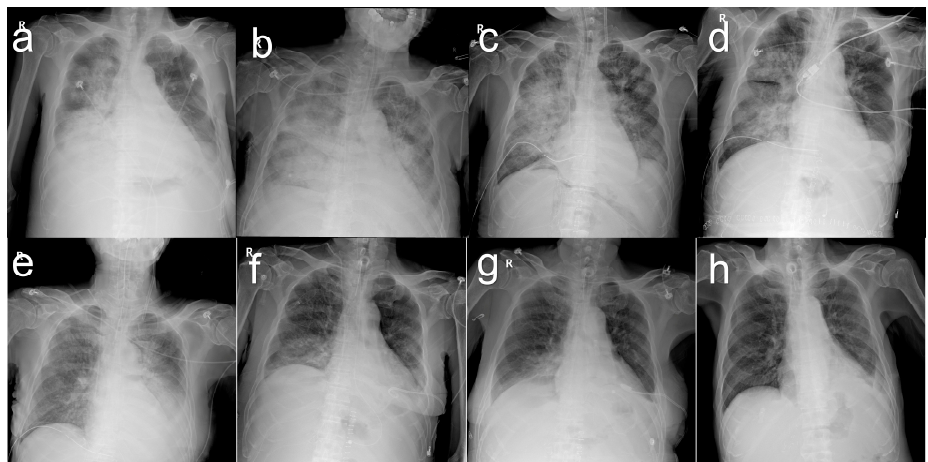
Figure 4. Series chest X-rays in the patient with pneumonia on pre-retransplant day 12 ( a ), preoperative day 0 ( b ), postoperative day 0 ( c ), postoperative day 4 ( d ), postoperative day 8 ( e ), postoperative day 16 ( f ), postoperative day 29 ( g ), and postoperative day 39 ( h ).